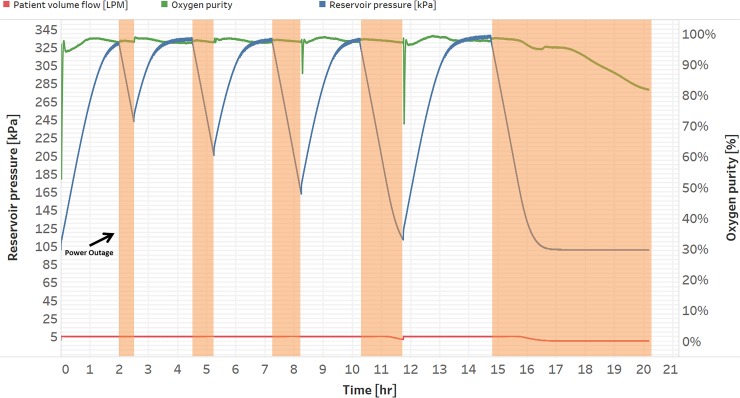
Laboratory test of the low-pressure reservoir system.Power outages were imposed on the system with intervals of 15 to 90 minutes in duration. The system flow rate was set at 5 liters per minute.